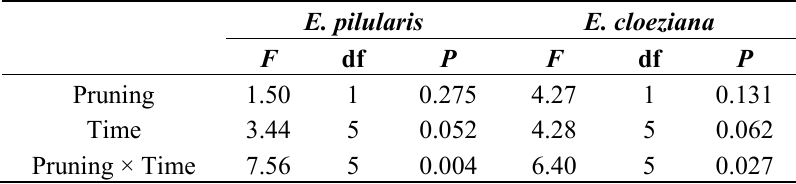
Table 3. Summary of repeated measures analysis of variance test conducted to determine the effects of pruning treatment (Pruning) on mean daily transpiration during six time periods (Time) of fine weather (one pre-pruning period and five post-pruning periods). Values are shown for variance ratio ( F ), degrees of freedom (df) and probability value ( P ). E. pilularis E. cloeziana F df P F df P Pruning 1.50 1 0.275 4.27 1 0.131 Time 3.44 5 0.052 4.28 5 0.062 Pruning × Time 7.56 5 0.004 6.40 5